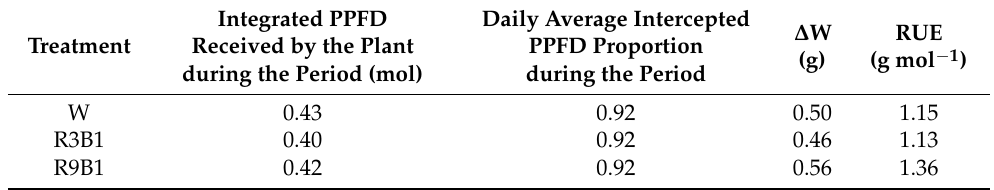
Table 7. Effects of light quality on light interception, biomass production, and RUE of ‘Micro-Tom’ during the 7-day experimental period in Experiment 2. ∆ W (g) is the total dry mass accumulated during the experimental period. Each value of ∆ W represents the average of six plants. RUE (g mol − 1 ) is defined as the ratio of the accumulated total dry mass to integrated PPFD received by the plant during the experimental period. W: white light; R3B1: red/blue ratio = 3; R9B1: red/blue ratio = 9. Integrated PPFD Daily Average Intercepted ∆ W RUE Treatment Received by the Plant PPFD Proportion (g) (g mol − 1 ) during the Period (mol) during the Period W 0.43 0.92 0.50 1.15 R3B1 0.40